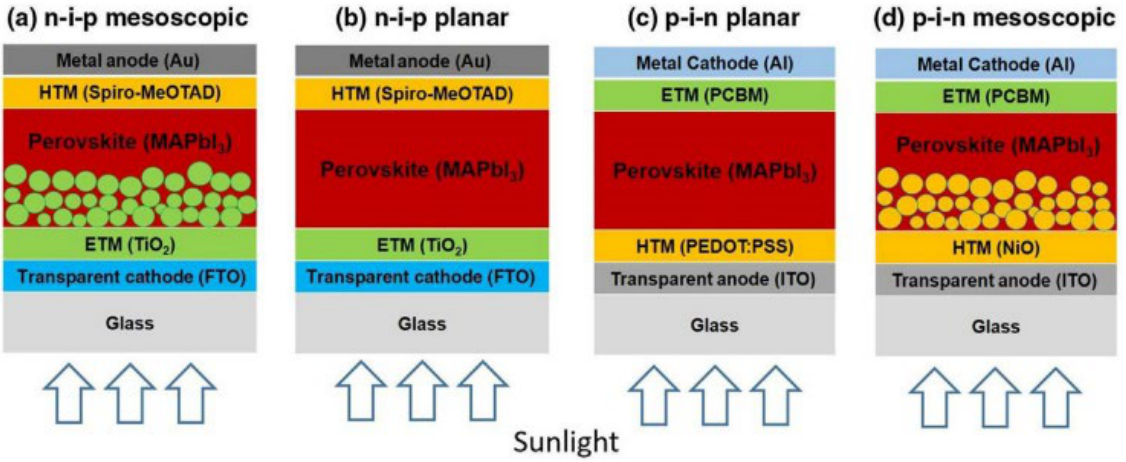
Figure 4. ( a , b ) represent simplified images of a conventional n-i-p PSC device architecture. ( c , d ) represent the inverted p-i-n PSC device architecture [40].